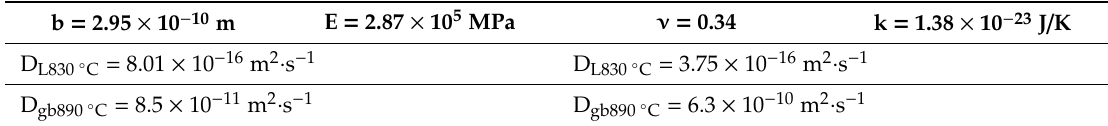
Table 4. Physical parameters of titanium alloy [41].